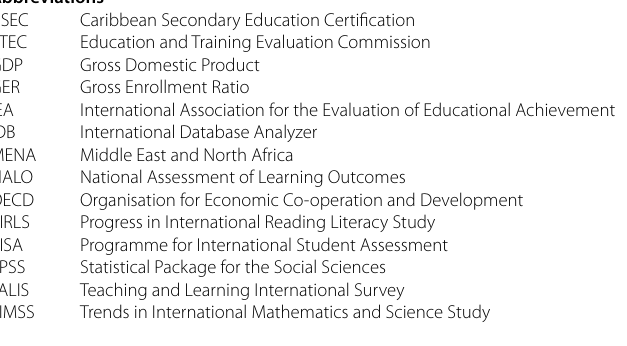
Table S6. Hierarchical two‑level regression model for mathematics achievement, grade 8, TIMSS 2019. Table S7. Hierarchical two‑level regression model for science achievement, grade 8, TIMSS